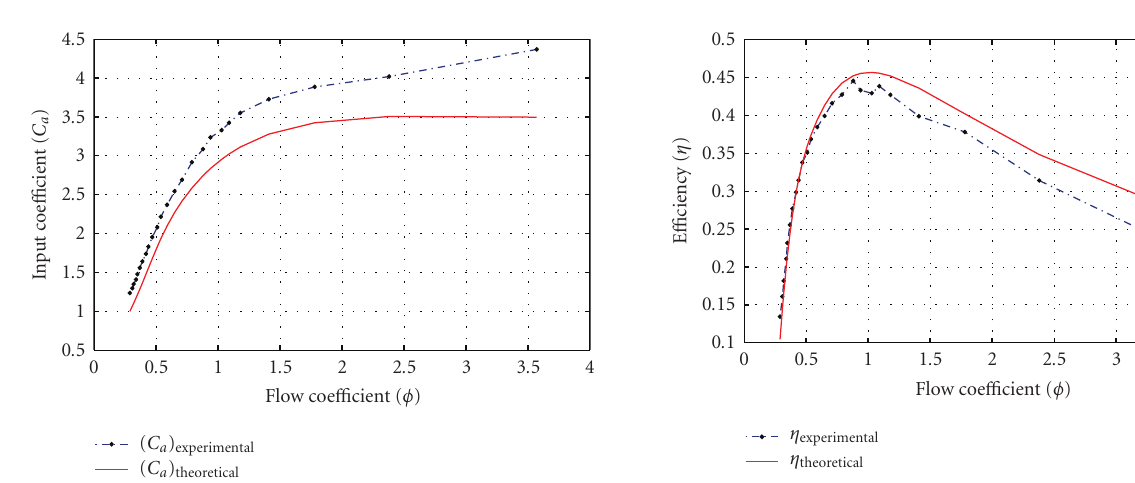
Figure 7: Turbine input coe ffi cient versus flow coe ffi cient [10].